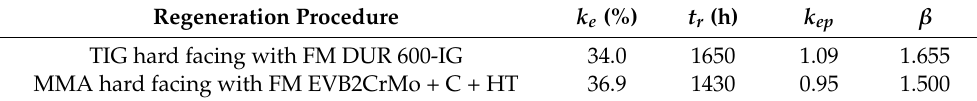
Table 11. Analysis is performed through the following parameters [27]: Table 11. Parameters of the techno-economic justification of the applied regeneration procedures. Regeneration Procedure k e (%) t r (h) k ep β TIG hard facing with FM DUR 600-IG 34.0 1650 1.09 1.655 MMA hard facing with FM EVB2CrMo + C + HT 36.9 1430 0.95